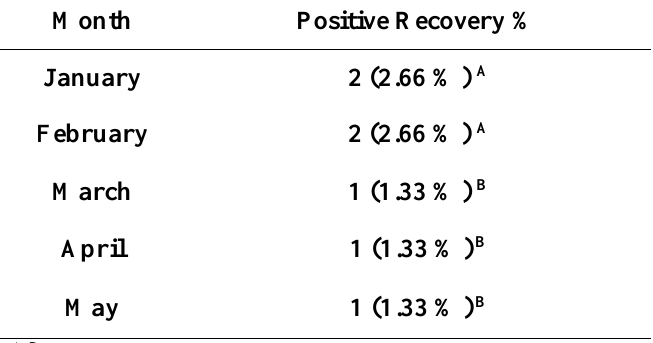
Table 2. Recovery of E. faecalis according to